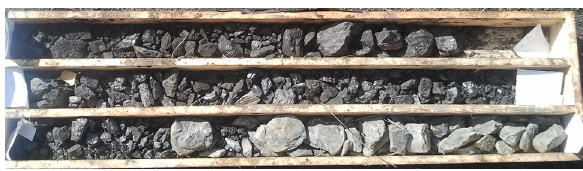
Fig. 2 Entirely crushed core from the floor of the work site